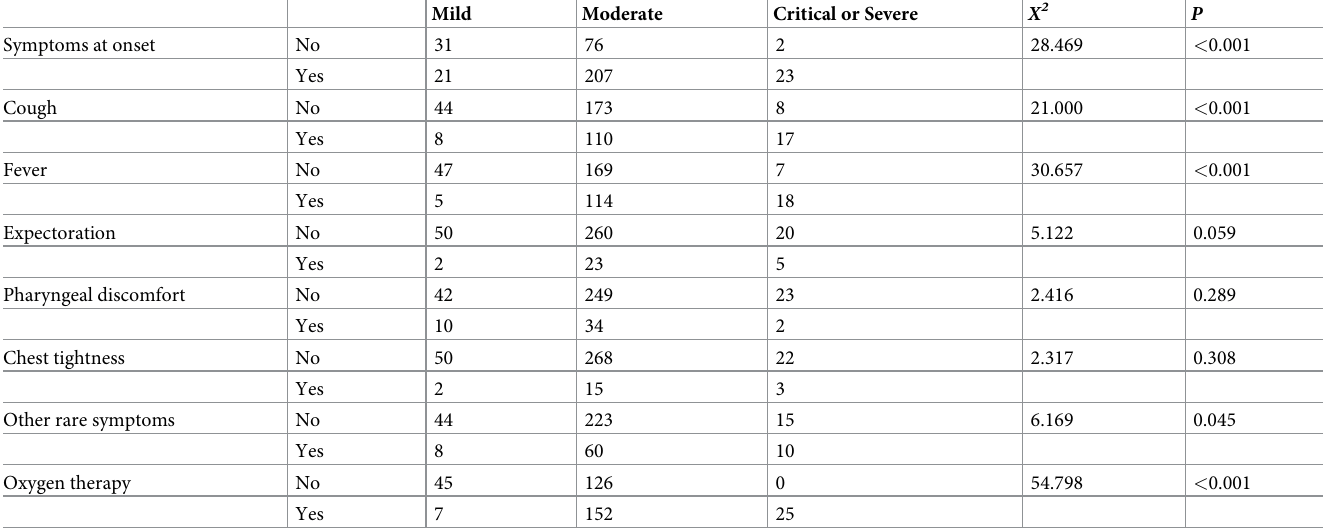
Table 5. Comparison of symptoms at onset and oxygen therapy between groups with different levels of disease